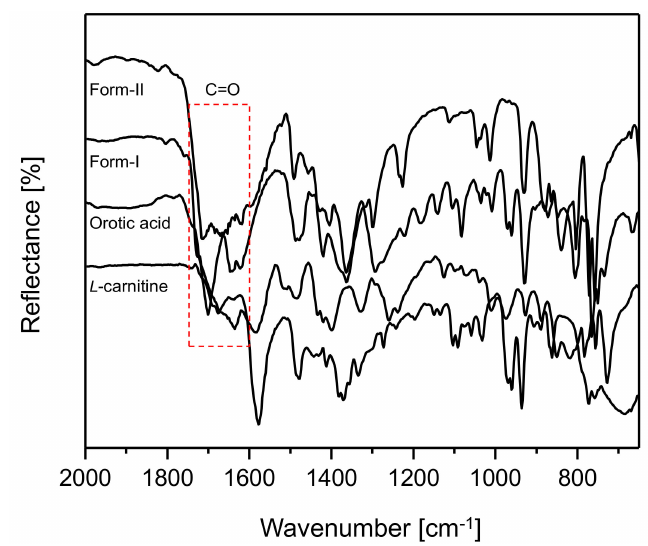
Figure 6. ATR FT-IR spectra for CO form-I and form-II, L -Carn and OA (2000 cm − 1 to 650 cm − 1 ).